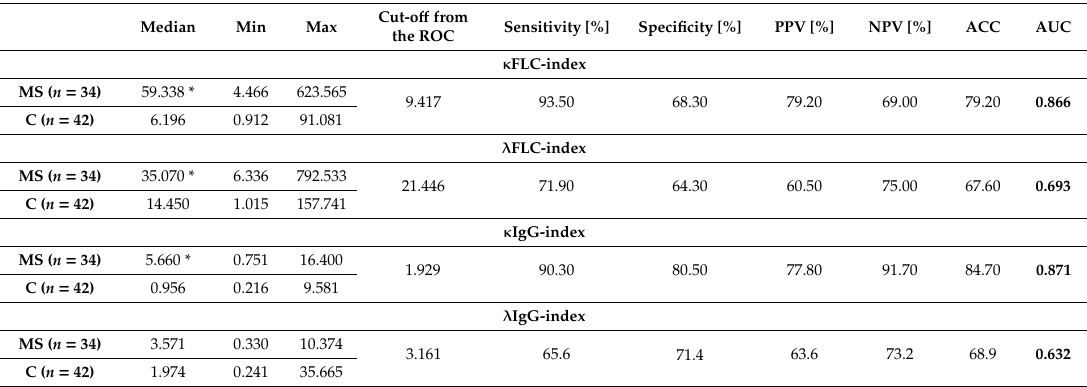
Table 2. Values of κ FLC index, λ FLC index, κ IgG index, and λ IgG index in multiple sclerosis patients and control group and their diagnostic significance.